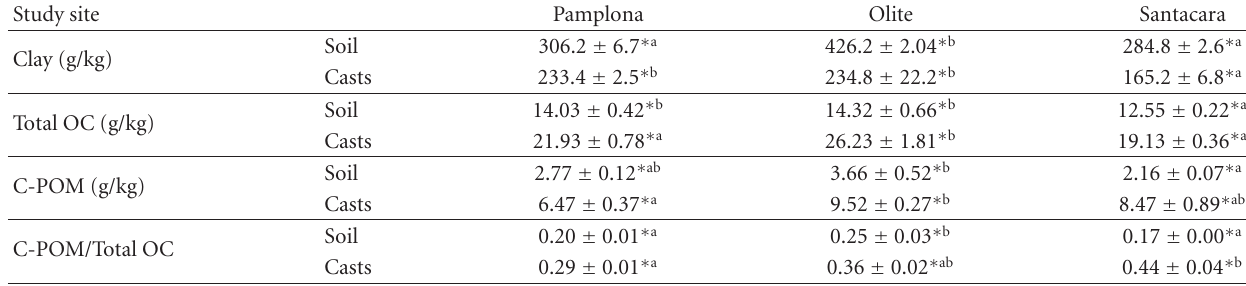
Table 2: Content in clay, total organic C, and C in the form of POM (C-POM) in bulk soil samples and in Scherotheca gigas casts at the three study sites. Values marked with ∗ are significantly di ff erent ( P < . 05) between soil and casts for each parameter and site. Values followed by the same letter in the same row belong to the same Duncan’s homogeneous groups ( P < . 05) for each parameter among sites. Means ± standard error ( n = 3).